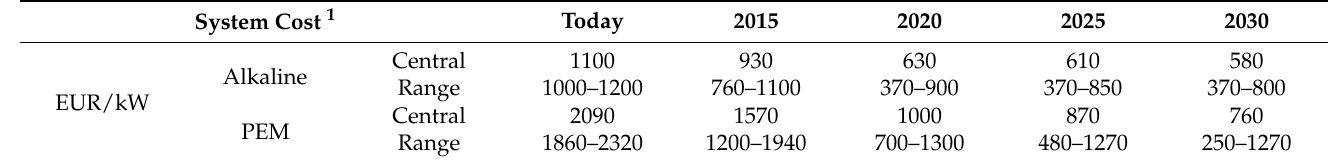
Table 15. System costs KPIs for alkaline electrolyzers (“Water Electrolysis in EU” FCH JU